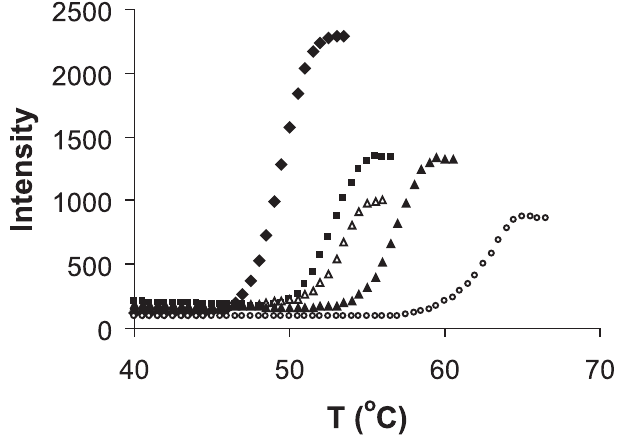
Figure 4. Thermo-denaturation/Aggregation Profile of SULT2A1 The intensity of scattered light is plotted as a function of temperature (T) for SULT2A1 in the absence of any ligand (filled diamond), and in the presence of AMP-PNP (filled square), lithocholic acid (open triangle), PAP (filled triangle), and both PAP and dehydroisoandrosterone 3-sulfate (open circle) . The inflection point of the denaturation curve is taken as T agg as reported in Table